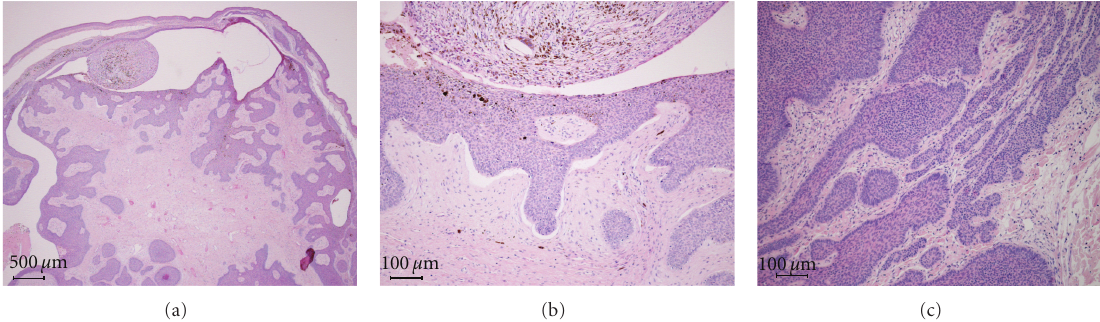
Figure 3: (a) Histological finding showed tumor masses mostly on the dermis with continuation from the epidermis in some parts. The tumor contains cystic spaces. (b) Clefts between the stroma and tumor edge are seen. (c) Palisading of the basaloid cells at the peripheral sites of the tumor masses is noticed.